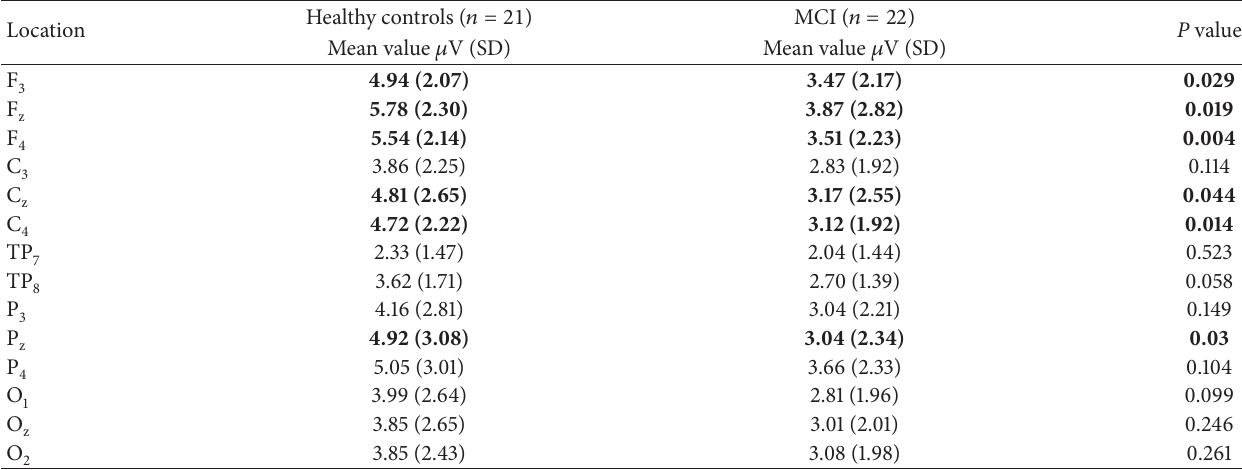
Table 2: Mean, standard deviation, and 𝑃 values of maximum peak-to-peak amplitudes of auditory target delta (0.5–2.2 Hz) oscillatory activity in healthy elderly controls and mild cognitive impairment (MCI)